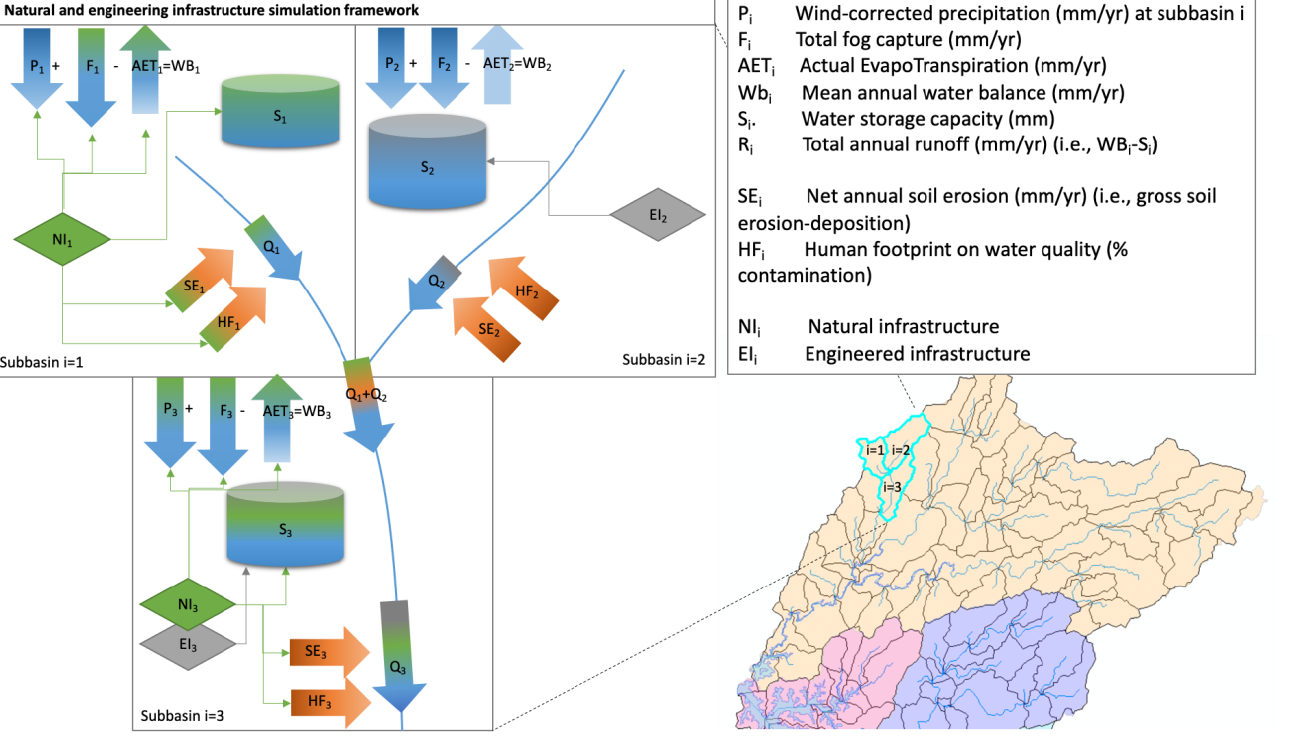
Figure A5. rcNEIS model framework shows the elements used in the simple water balance accounting. Changes in water balance, in terms of wind-corrected precipitation, fog capture, and actual evapotranspiration (AET), and changes in land surface, in terms of CN , can be entered (user input can be defined in terms of different conservation actions, and their effects on water balance and infiltration can be quantified from literature review and stakeholder/expert inputs) at the zone-level. The model will modify the water balance and infiltration capacity for all subbasins in each zone according to the user input in the table below (spatial resolution for conservation scenario inputs can be made finer than the zone-level proposed here). For example, entering 25% for “Fog capture” in zone 1 will result in a 25% increase in fog capture in all subbasins in zone 1. Likewise, entering − 10% in “Land-cover” in zone 2 will result in a decrease in curve number by 10% to simulate higher infiltration